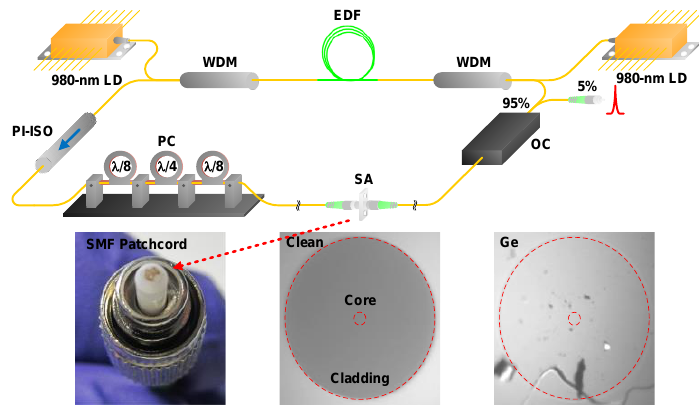
Figure 1. Experimental setup of the passively mode-locked EDFL self-started by the Ge-based SA.